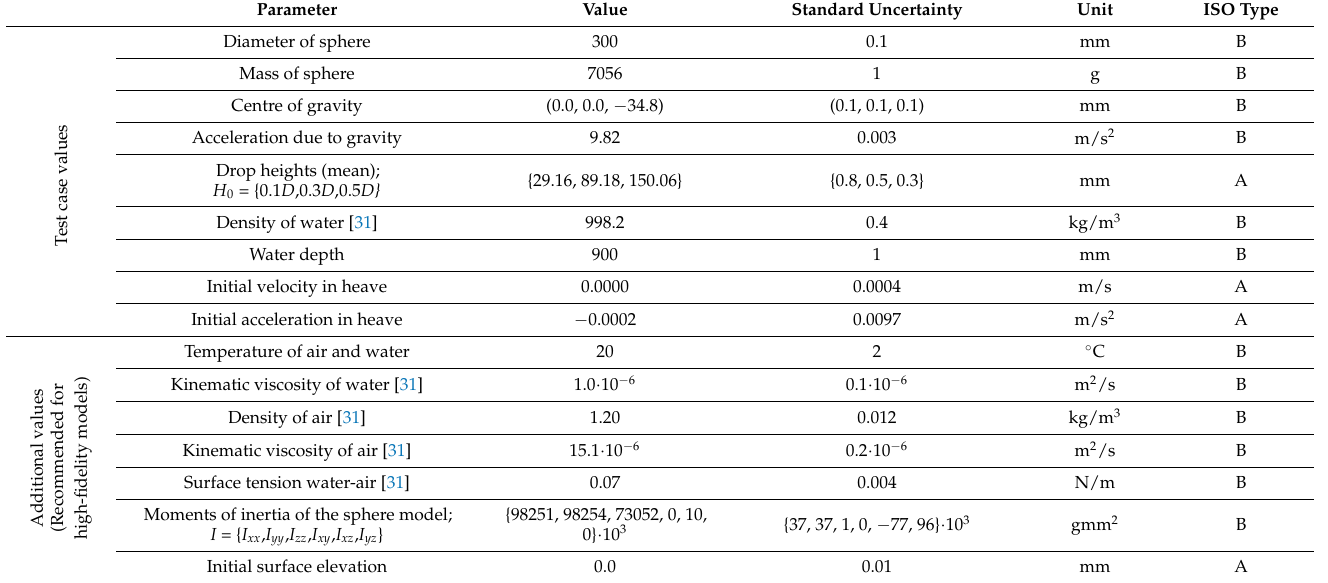
Table 4. Values and standard uncertainties for physical parameters in the test setup.